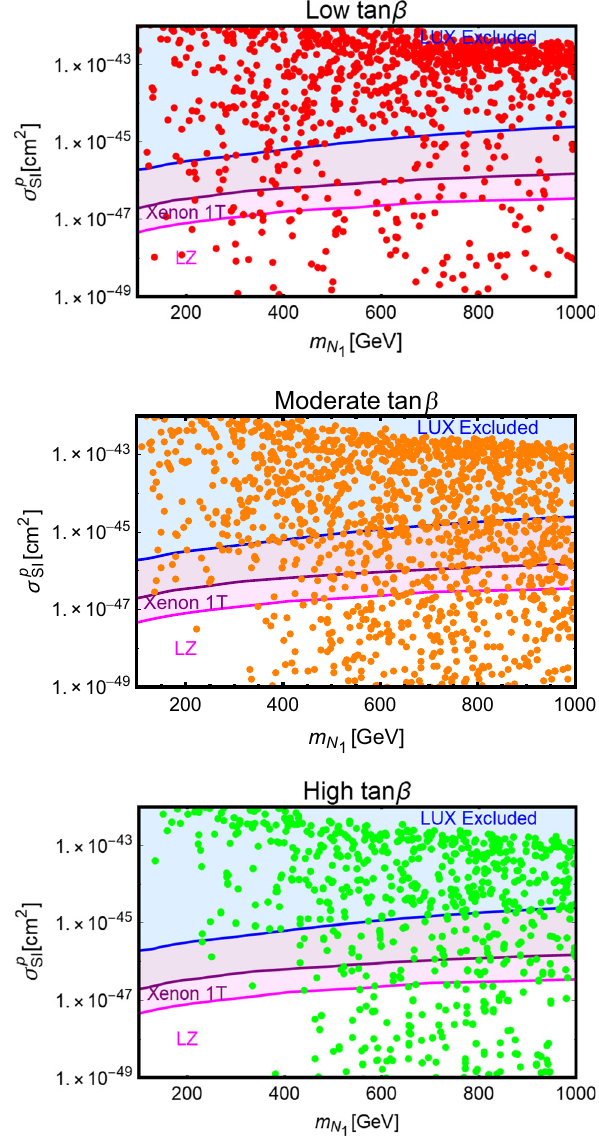
Fig. 18 Summary plots including all the constraints discussed throughout this work. Each of the three panels of the figure refers to a different regime of values of tan β (see main text for details), indicated on the top of each